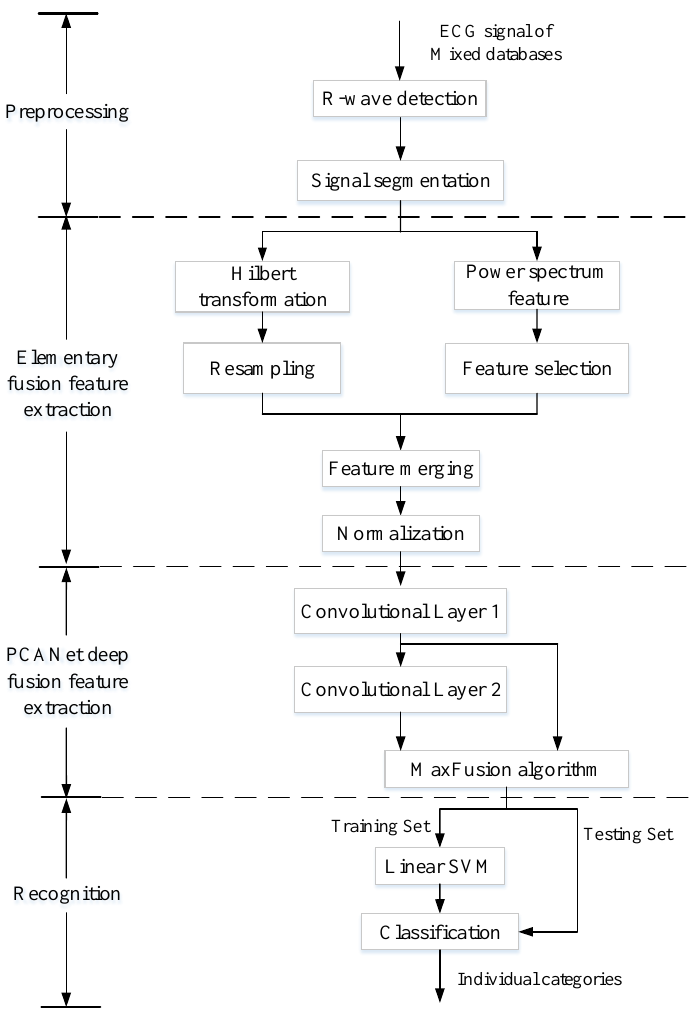
Figure 1. The overall architecture of the two-level fusion feature identity recognition network.